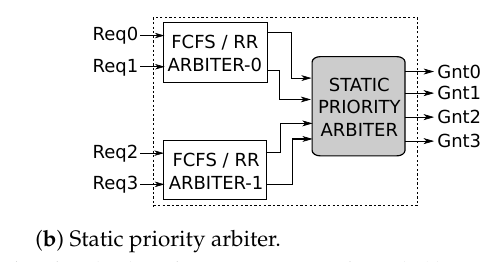
Figure 9. First-Come-First-Serve (FCFS)/Round-Robin (RR) and static-priority arbiter ( a , b